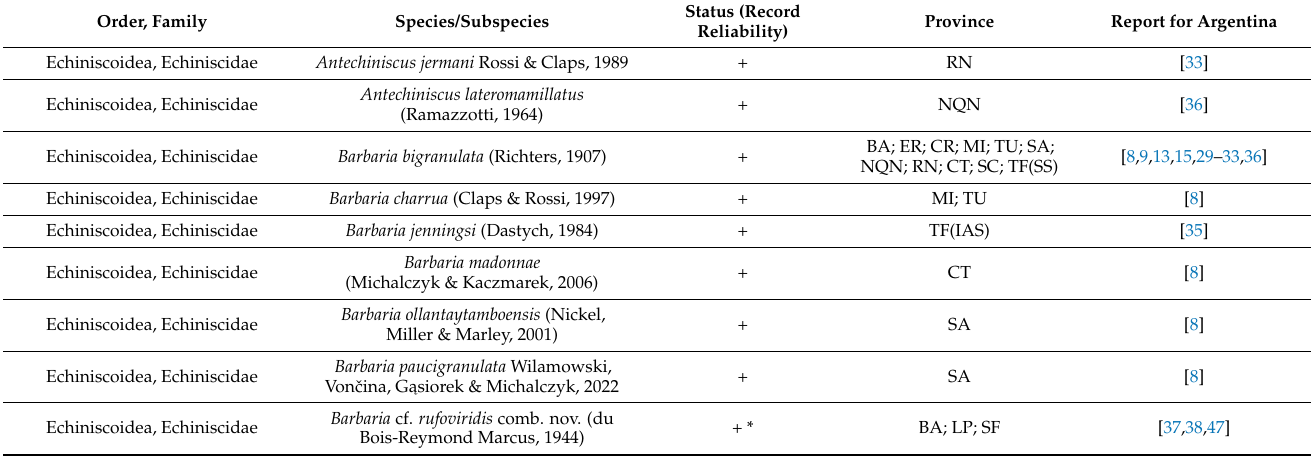
Figure 1. Map of Argentina showing the until now investigated sites. Table 1. List of valid species reported in Argentina from the literature. Status (record reliability): + = species reported with certainty; + * = species that need a diagnosis confirmation but each one representing a separate taxon from any other in Argentina; N = dubious record that cannot be taken into consideration because it may coincide with other species in the list. Province abbreviations: BA = Buenos Aires; CB = C ó rdoba; CH = Chaco; CR = Corrientes; CT = Chubut; ER = Entre R í os; JY = Jujuy; LP = La Pampa; MI = Misiones; NQN = Neuqu é n; RN = R í o Negro; SA = Salta; SC = Santa Cruz; SF = Santa F é ; SJ = San Juan; TF(IAS) = Isla de Atl á ntico Sur; TF(SS) = Tierra del Fuego; TU = Tucum á